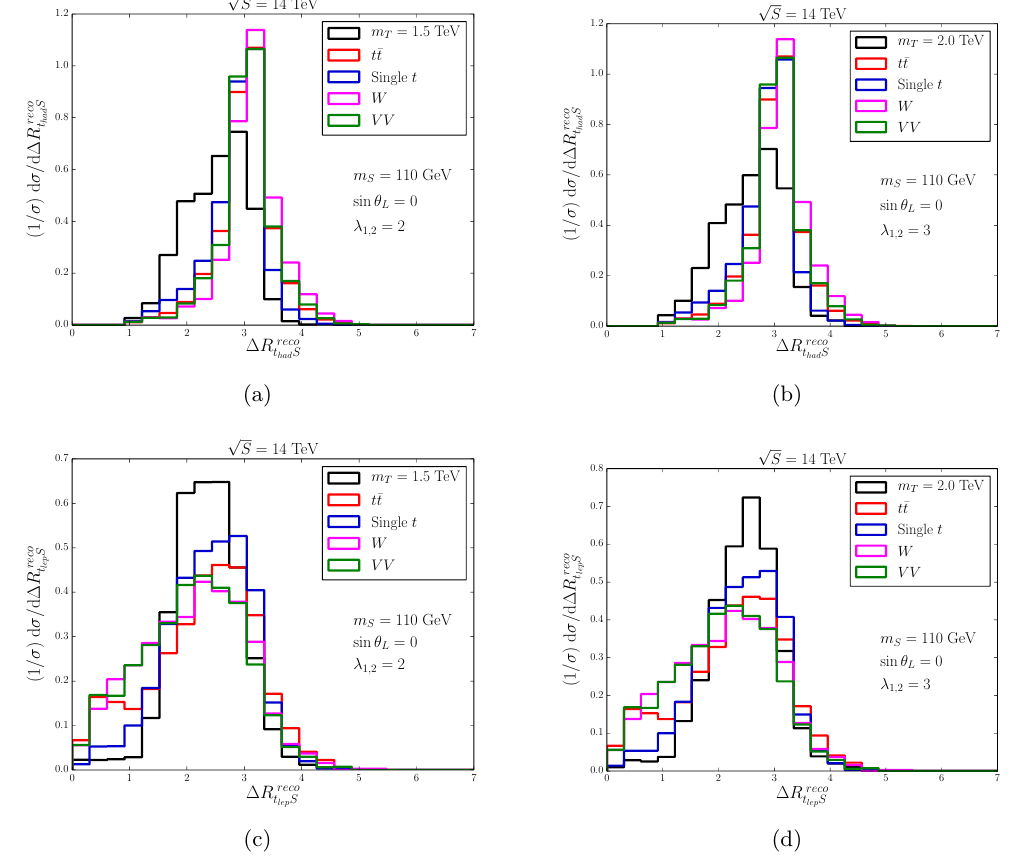
Figure 20 . Distributions of the angular separation between (a,b) the reconstructed S and hadron- ically decaying top, (cid:1) R reco , and (c,d) the reconstructed S and leptonically decaying top, (cid:1) R reco t had S for (a,c) m T = 1 : 5 TeV and (b,d) m T = 2 TeV. All plots are generated based on events after show- ering, hadronization, and detector e(cid:11)ects. The other model parameters are set to m S = 110 GeV and sin (cid:18) L = 0. The coupling constants are (cid:21) 1 ; 2 = 2 for m T = 1 : 5 TeV and (cid:21) 1 ; 2 = 3 for m T = 2 TeV. Basic cuts in eqs. (6.8){(6.11) have been